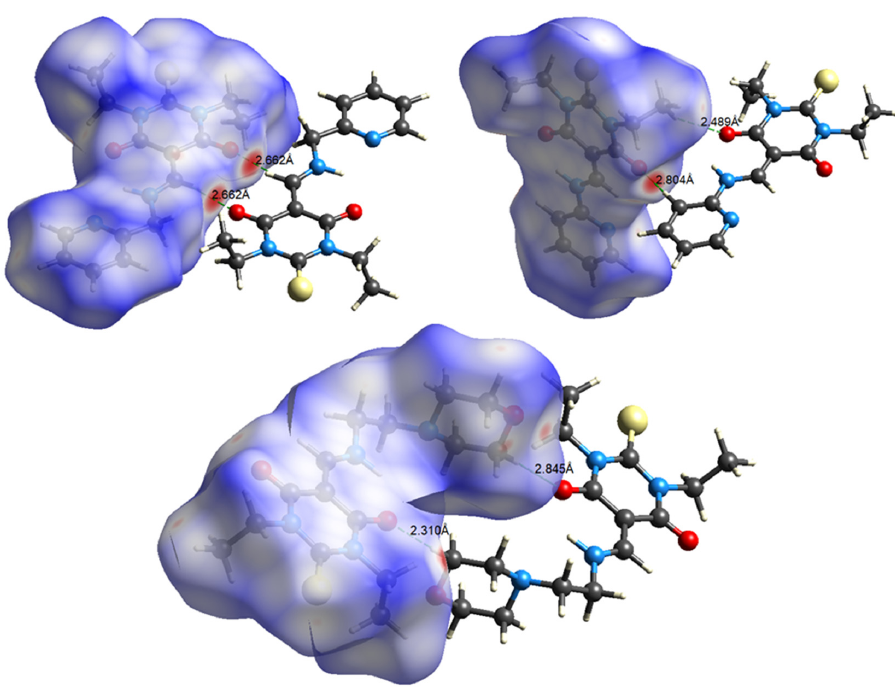
Figure 8. Hirshfeld surfaces mapped with d norm shape-index and curvedness properties along with molecular pairs involving hydrogen bond interactions.